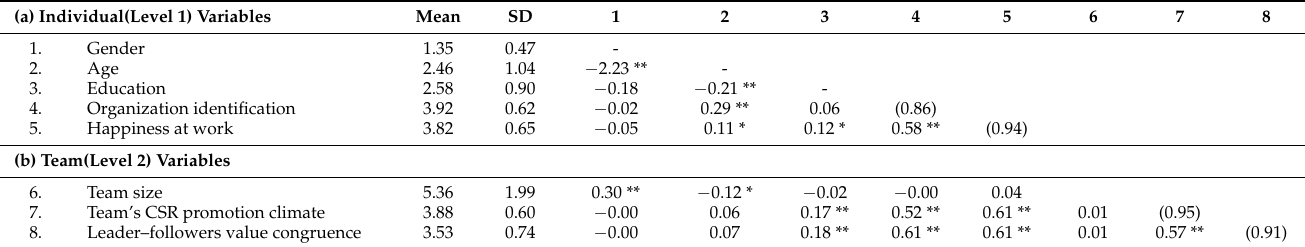
Table 3. Descriptive Statistics and